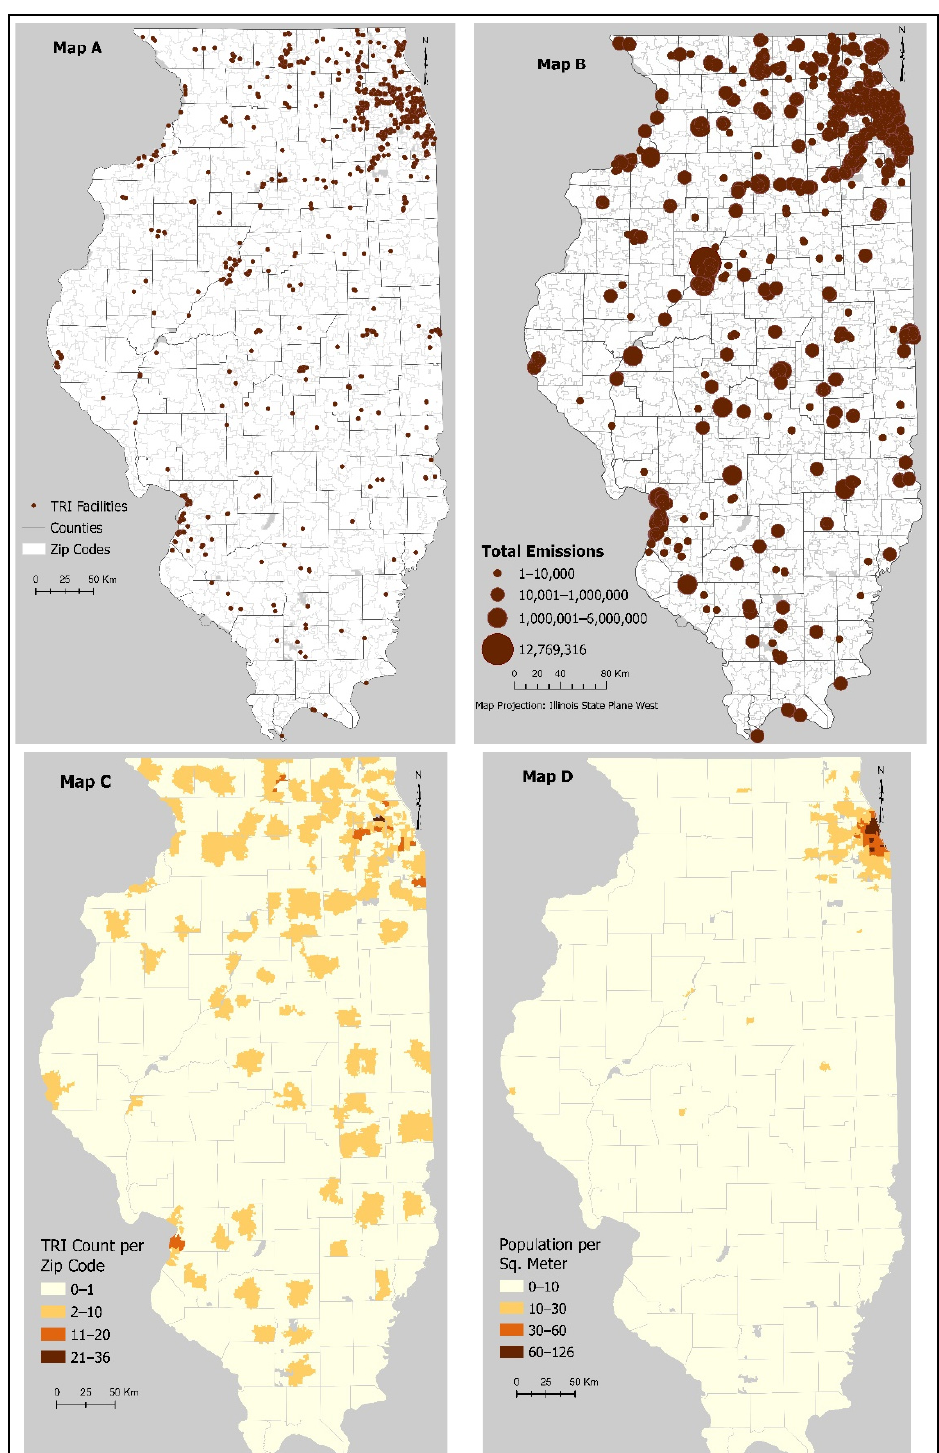
Figure 1. ( A ) TRI Counts, ( B ) Emissions, and ( C ) Counts per Zip Code along with ( D ) Population Density for Illinois in